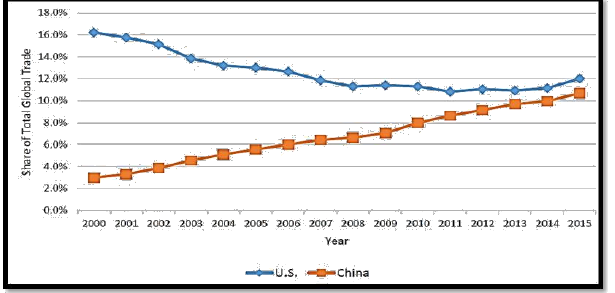
Figure 1: Global Trade Distribution Diagram: the US and China (Source: Walter and Tukachinsky